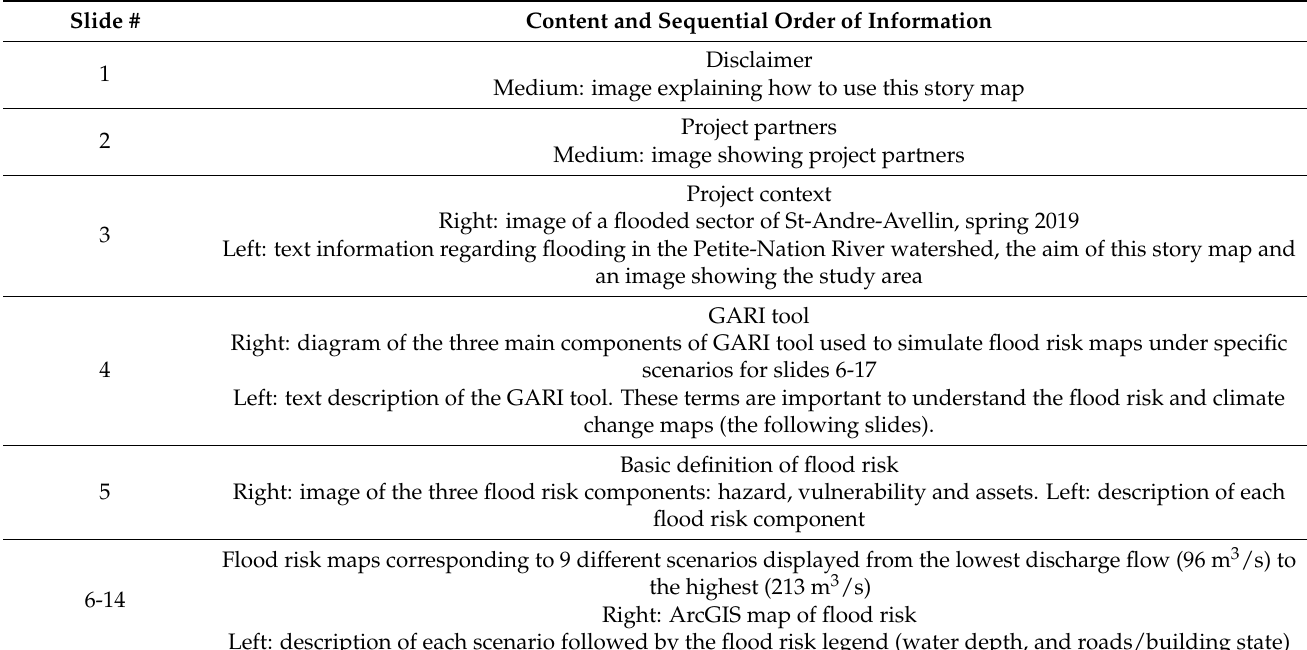
Table 5. Story map slide